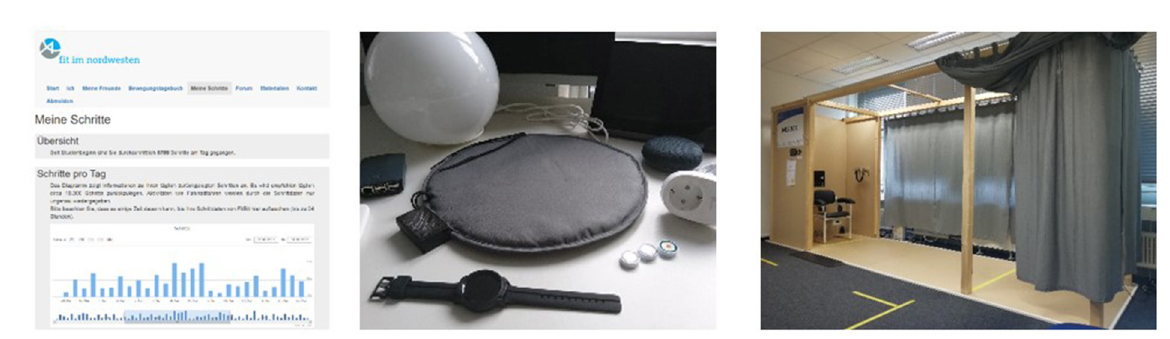
FIGURE1 The novel technologies evaluated in (left) the PROMOTE-intervention-study– the website presenting the participants’ daily activities, (center) the ActiThings motivation – interactive devices such as a tablet pc, pressure sensitive cushion, smart watch, plugs, lights and speakers that monitor the participants’ behavior and remind of physical activity, and (right) the VERSA assessment studies – a measurement box equipped with multiple devices for unsupervised conduction of standard geriatric